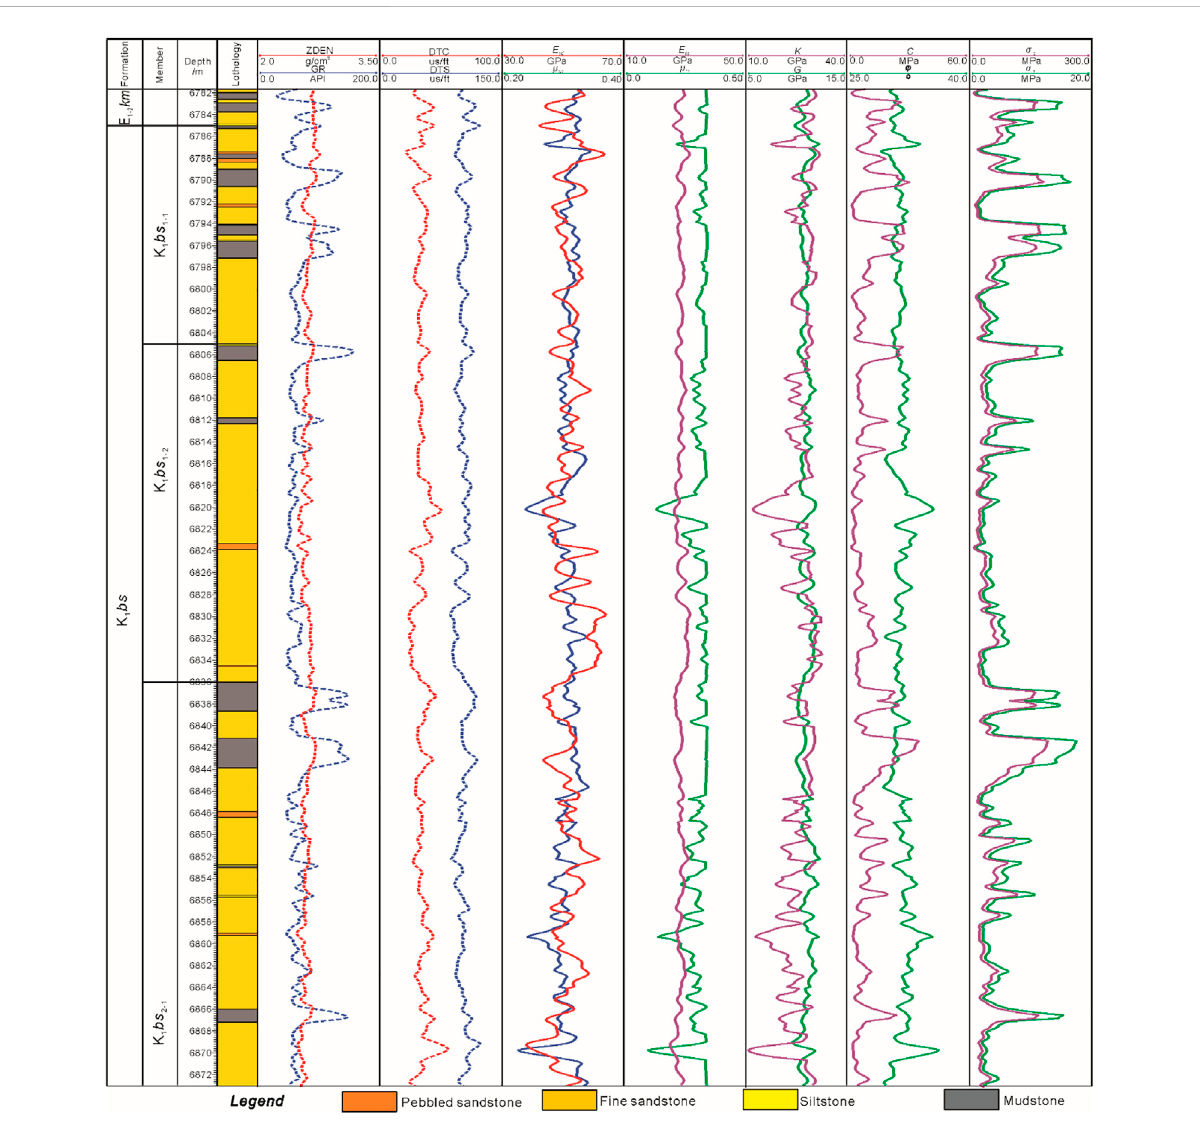
FIGURE 6 Comprehensive columnar section of rock mechanics parameters in the K 1 bs of the K15 well. Here, ZDEN is the litho-density logging, GR is the naturalgammalogging,DTCistheP-wavetimedifferencelogging,DTSistheS-wavetimedifferencelogging, E td isthedynamicYoung ’ smodulusof rock, μ td isthedynamicPoisson ’ sratioof rock, E td isthecorrected static Young ’ smodulusofrock, μ ts isthecorrected static Poisson ’ sratio ofrock, K isthebulkmodulus ofrock,and K = E /[3×(1-2 μ )], G istheshearmodulusofrock,and G = E /[2×(1+ μ )], φ istheinternalfriction angleofrock, σ c is the compressive strength of rock; σ t is the tensile strength of